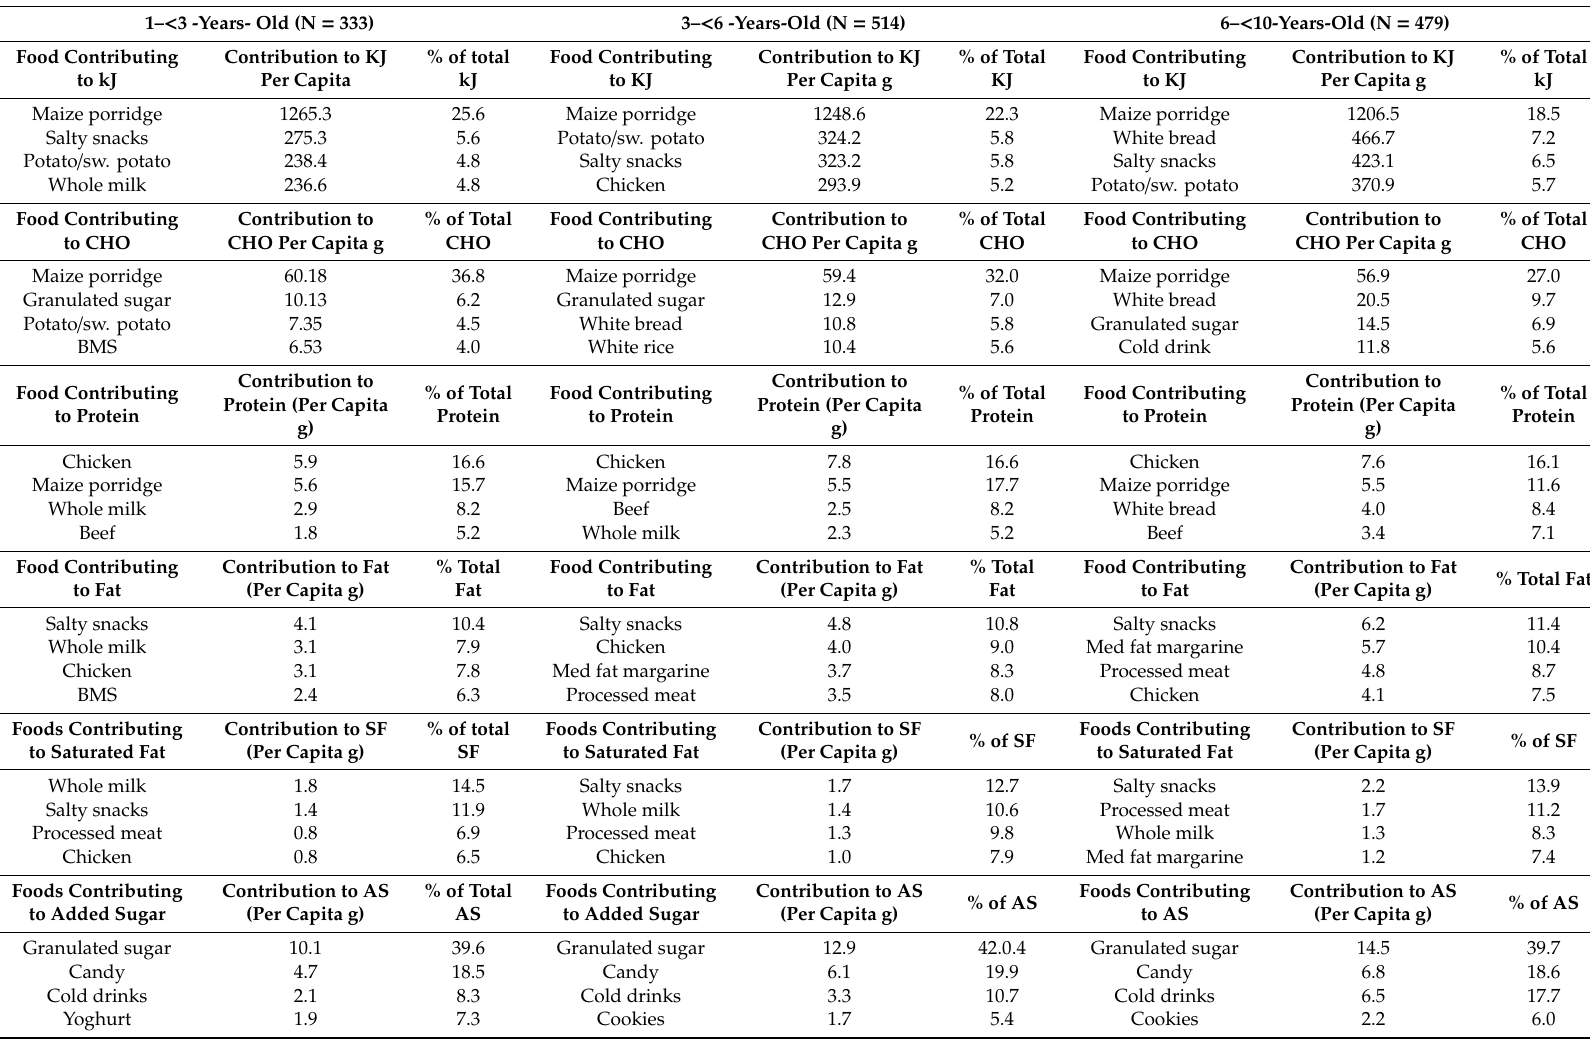
Table 5. The four main foods contributing to total energy and macronutrient intake of 1– < 10-year-olds in both provinces by age